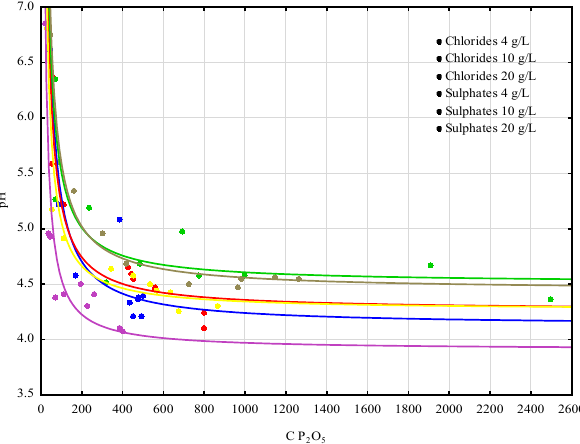
O concentration in 2 5